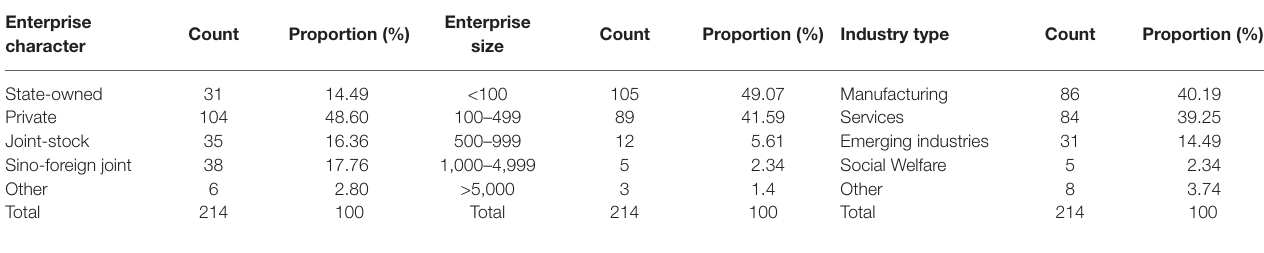
TABLE 1 | Descriptive statistics of the